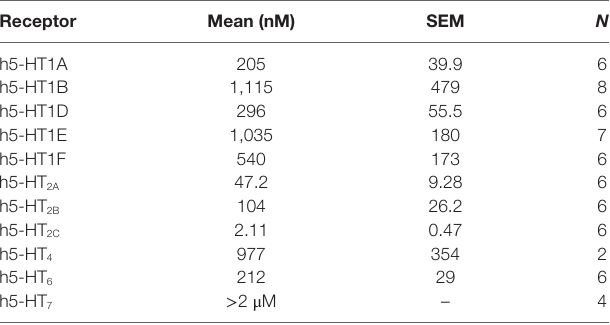
TaBle 1 | affinity was measured using standard radioligand binding techniques employing agonist